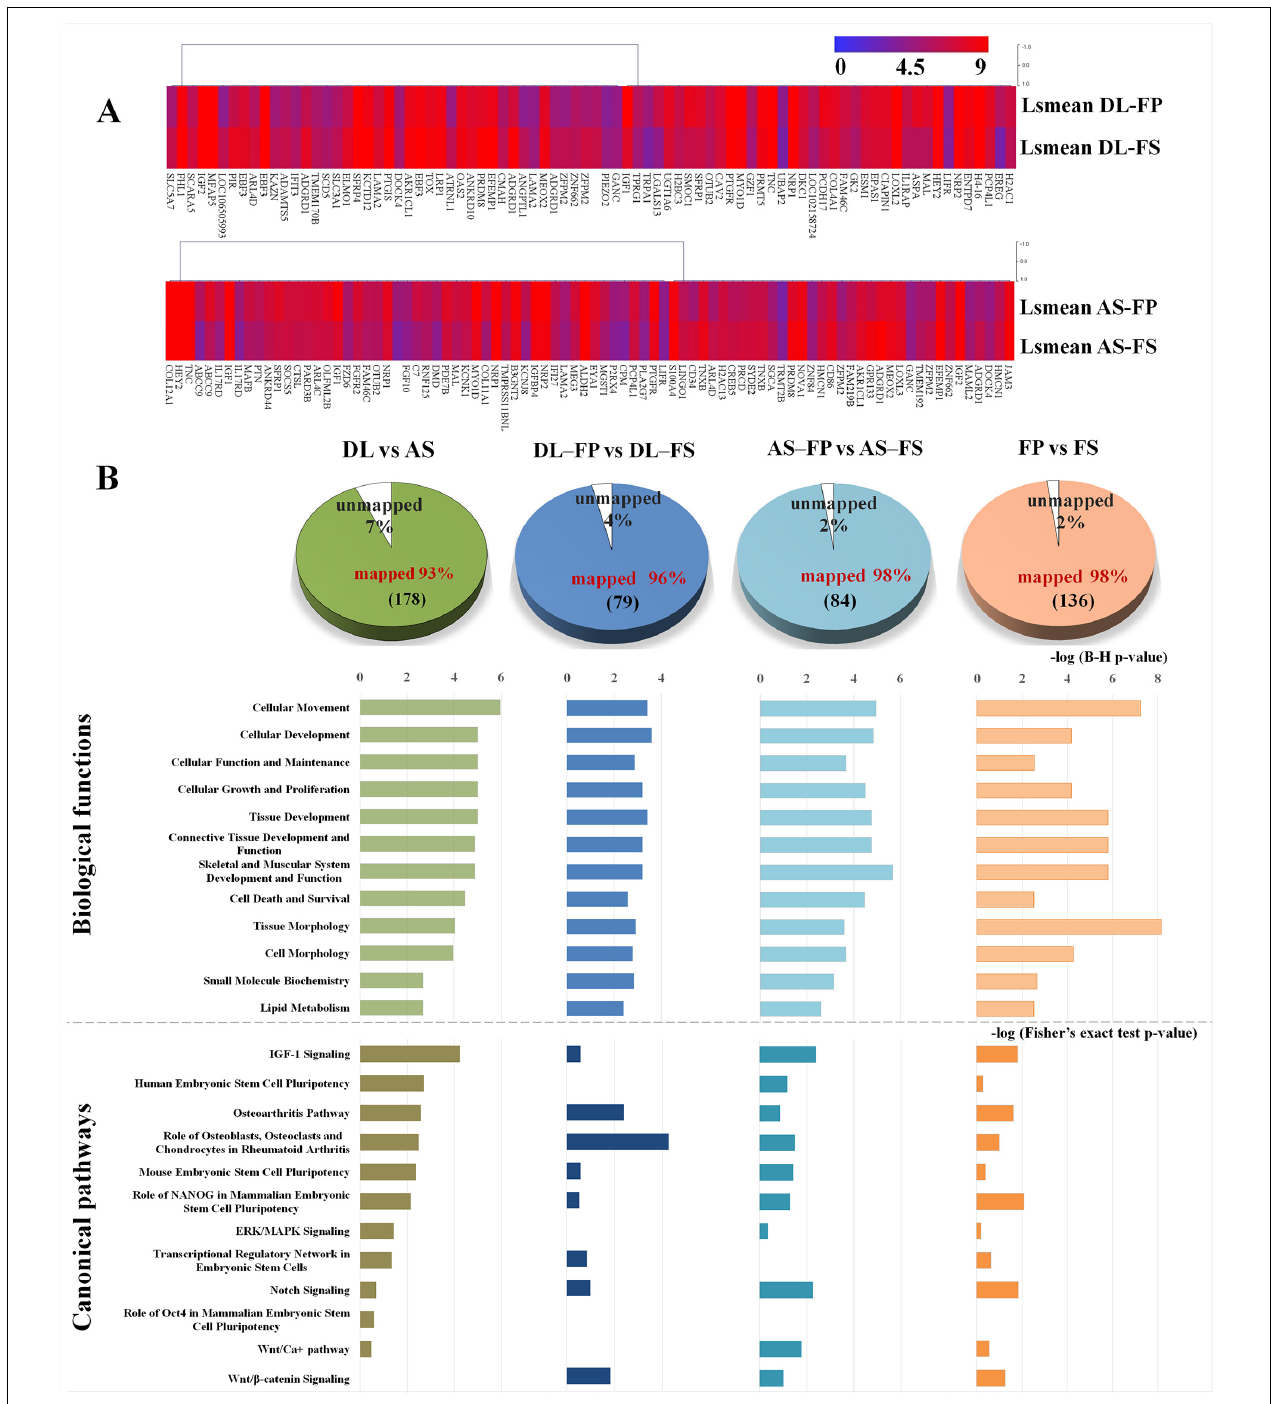
FIGURE 5 | Graphs summarizing results of expression profiling and subsequent functional annotation analyses of SMSC derived from FP and FS of DL and AS breeds. (A) Heat-map of differentially expressed genes between FP and FS derived SMSCs within the breeds, DL or AS.; Expression levels are indicated by the color with red color indicating high expression (set to 9) and blue color indicating low expression (set to 0). Genes were clustered according to their transcription patterns using MeV 4.9.0 (Saeed et al., 2003). (B) The number of significant DEGs submitted to Ingenuity Pathway Analysis (IPA) and thereof the proportion of un-mapped and mapped transcripts ( Supplementary Table 2 ). Twelve categories of biological functions (light colored bars) and canonical pathways (dark colored bars) enriched for DEGs in the respective comparisons by breed, by synovial tissue type and by or different synovial tissue types in each breed ranked by significance (negative log of B–H multiple testing corrected p -values at scale on top of bars or negative log of Fisher’s exact test p -values at scale below the bars).